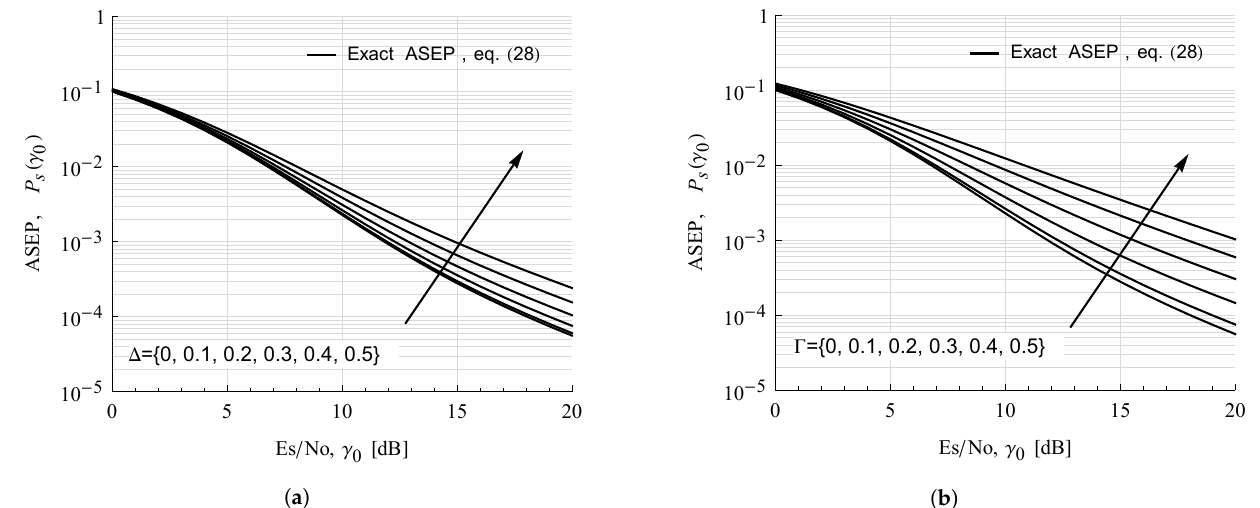
Figure 6. BPSK ASEP in TWDP channel for K = 6 and different values of parameter ( a ) ∆ ( b ) Γ